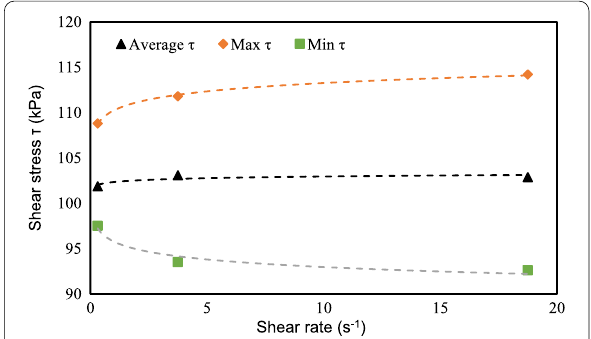
Fig. 6 Relationship between the shear rate and the residual shear stress